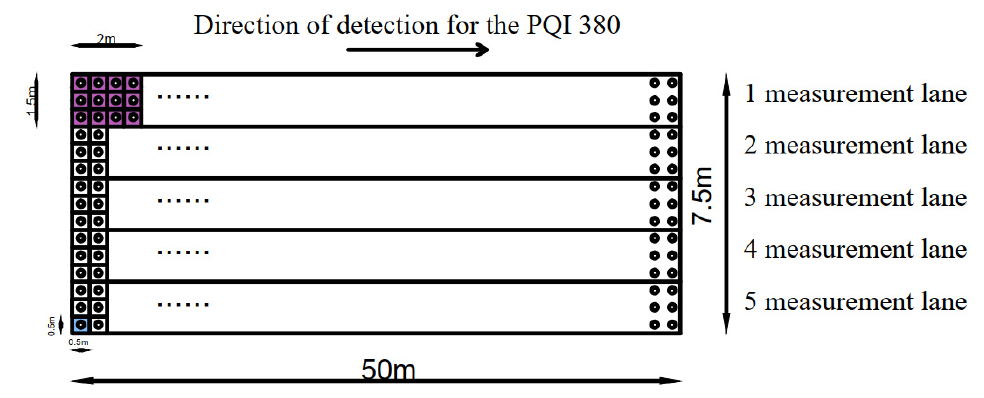
Figure 10. PQI 380 detection distribution map.